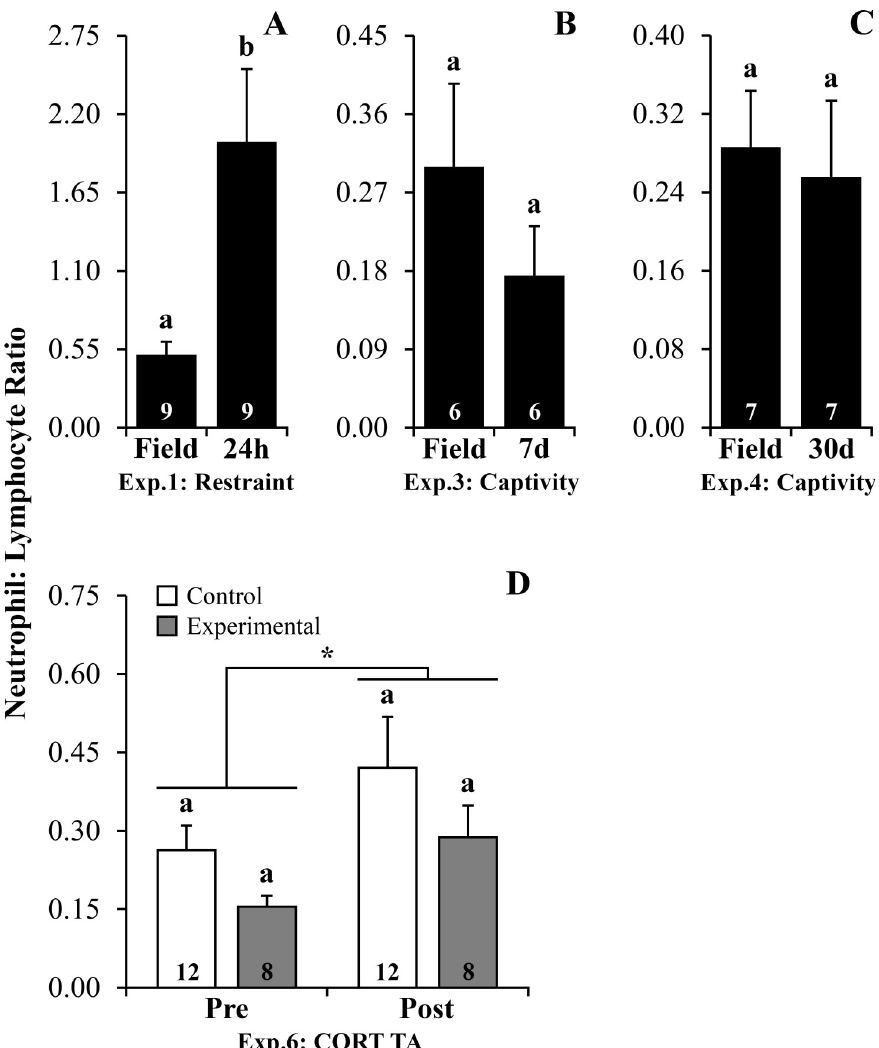
Fig 2. Neutrophil Lymphocyte ratio following stressors and corticosterone transdermal application in R . ornata toads. (A) Experiment 1: Restraint–field vs . 24h. (B) Experiment 3: Captivity–field vs . 7 days. (C) Experiment 4: Captivity–field vs . 30 days. (D) Experiment 6: Corticosterone transdermal application. Bars represent mean ± standard error. The N is indicated inside each bar. Letters above the bars represent statistical differences for Bonferroni adjustments in ANOVAs or Student t-test, with different letters representing statistical difference within groups with P � 0.05. Asterisk represents statistical differences between pre and post-treatment, independently of the treatment (Control and experimental groups). Abbreviation: Exp.: Experiment; CORT TA: Corticosterone transdermal application. Legend: Control: control and placebo group; Experimental: corticosterone group.